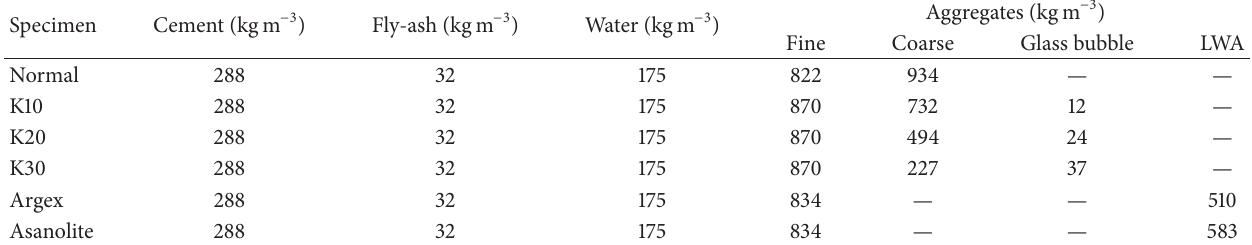
Table 2: Mix proportions.